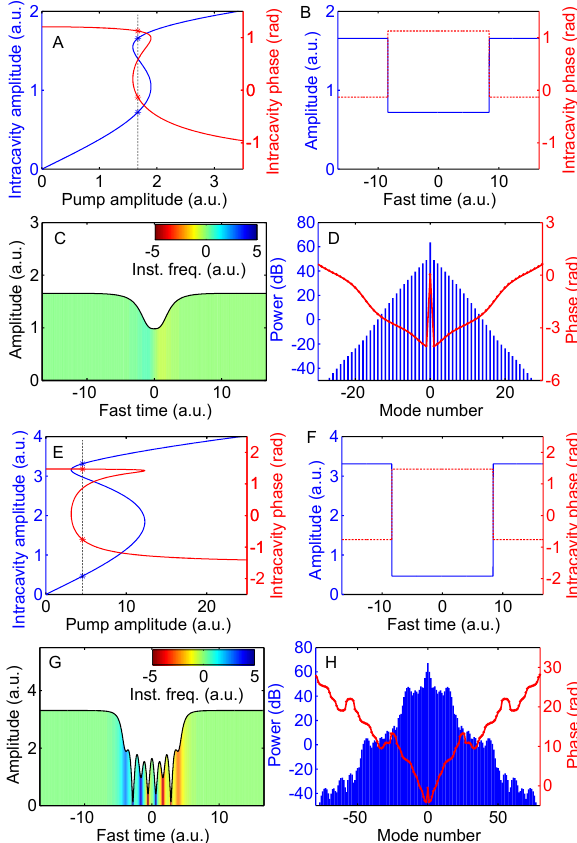
Figure 18: Dark pulse formation from two well-separated switching waves. (A, E) Bistability curve. (B, F) Initial waveform. (C, G) Dark pulse evolved from the initial waveform. Inst. freq.: instantaneous frequency. (D, H) Corresponding comb spectra. The simulations